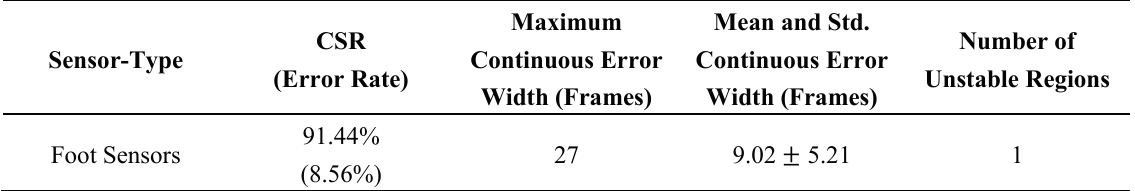
Table 6. Online classification results of walking phase classifiers with foot